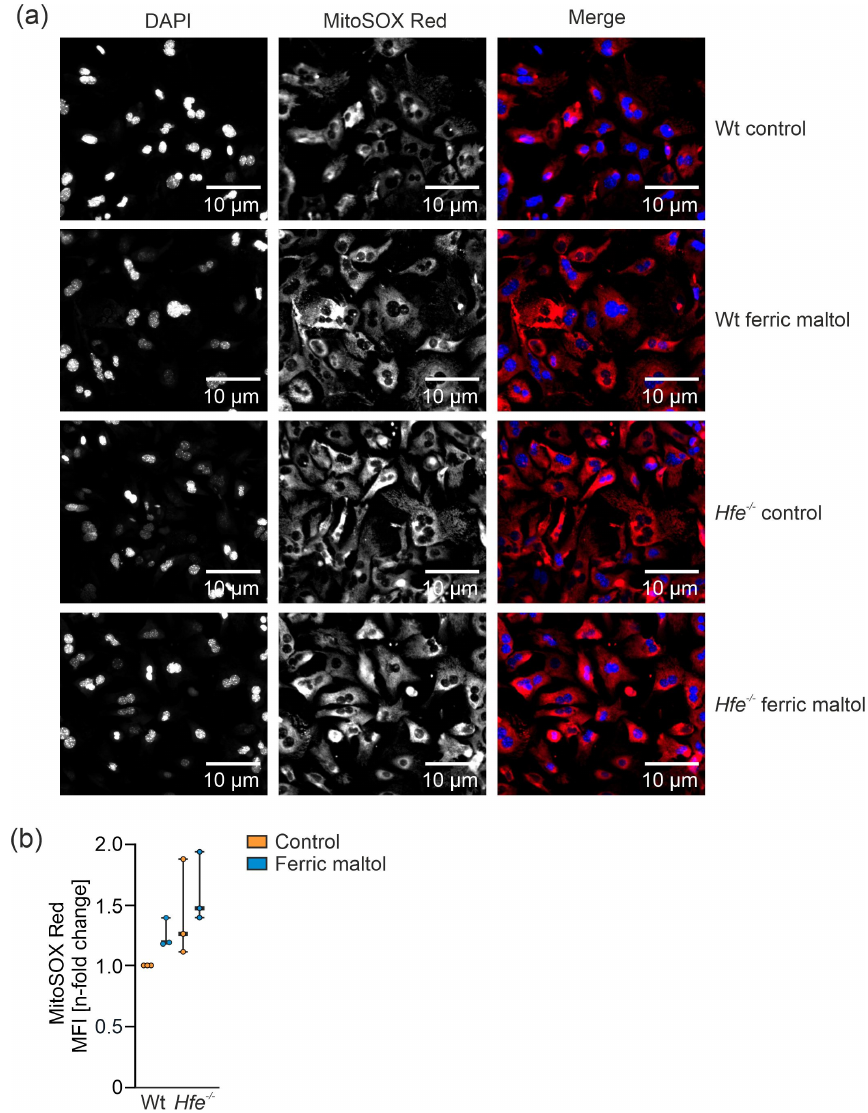
Figure 8. Determination of mitochondrial superoxide formation in primary murine hepatocytes from Wt and Hfe − / − mice in the presence or absence of the iron source ferric maltol (100 µ M for 48 h). ( a ) Immunofluorescence images of primary murine hepatocytes isolated from Wt and Hfe − / − mice treated with 100 µ M ferric maltol for 48 h were stained with MitoSOX (red; mitochondrial superoxide) and DAPI (blue; nuclei). Scale bar = 10 µ m. ( b ) Flow cytometry analysis of mitochondrial superoxide formation in primary murine hepatocytes; the graph summarizes three independent experiments performed in triplicates ( n = 3 mice per group, n = 3 replicates). MFI: mean fluorescence intensity. Two-way ANOVA: ( b ) Ferric maltol, F (1,8) = 2.227, p = 0.1740; genotype, F (1,8) = 6.608, p = 0.0331; ferric maltol X genotype, F (1,8) = 0.04869, p = 0.8309. Values are shown as median ± interquartile